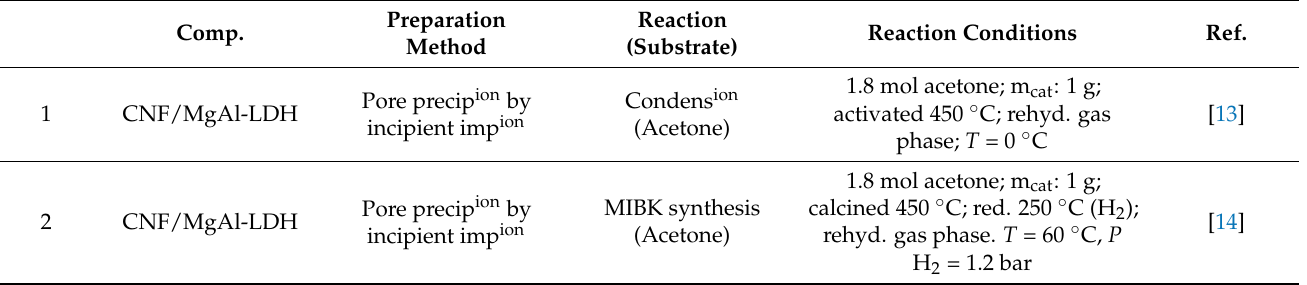
Table 2. Composition and preparation method of the LDH/nanocarbon composites, and catalytic reactions